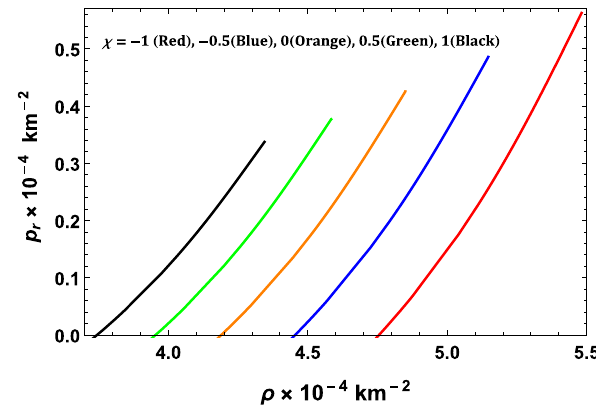
Fig. 9 Velocity of sound profiles of SMC X-4 for M = 1 . 29 M (cid:9) , R = 8 . 831 km and b = 0 . 0031km − 2